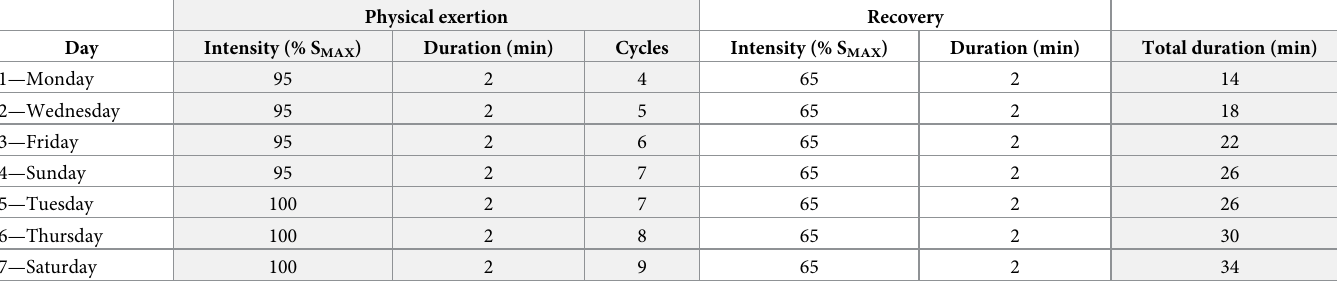
Table 2. Description of training sessions of the HIIT 100% .